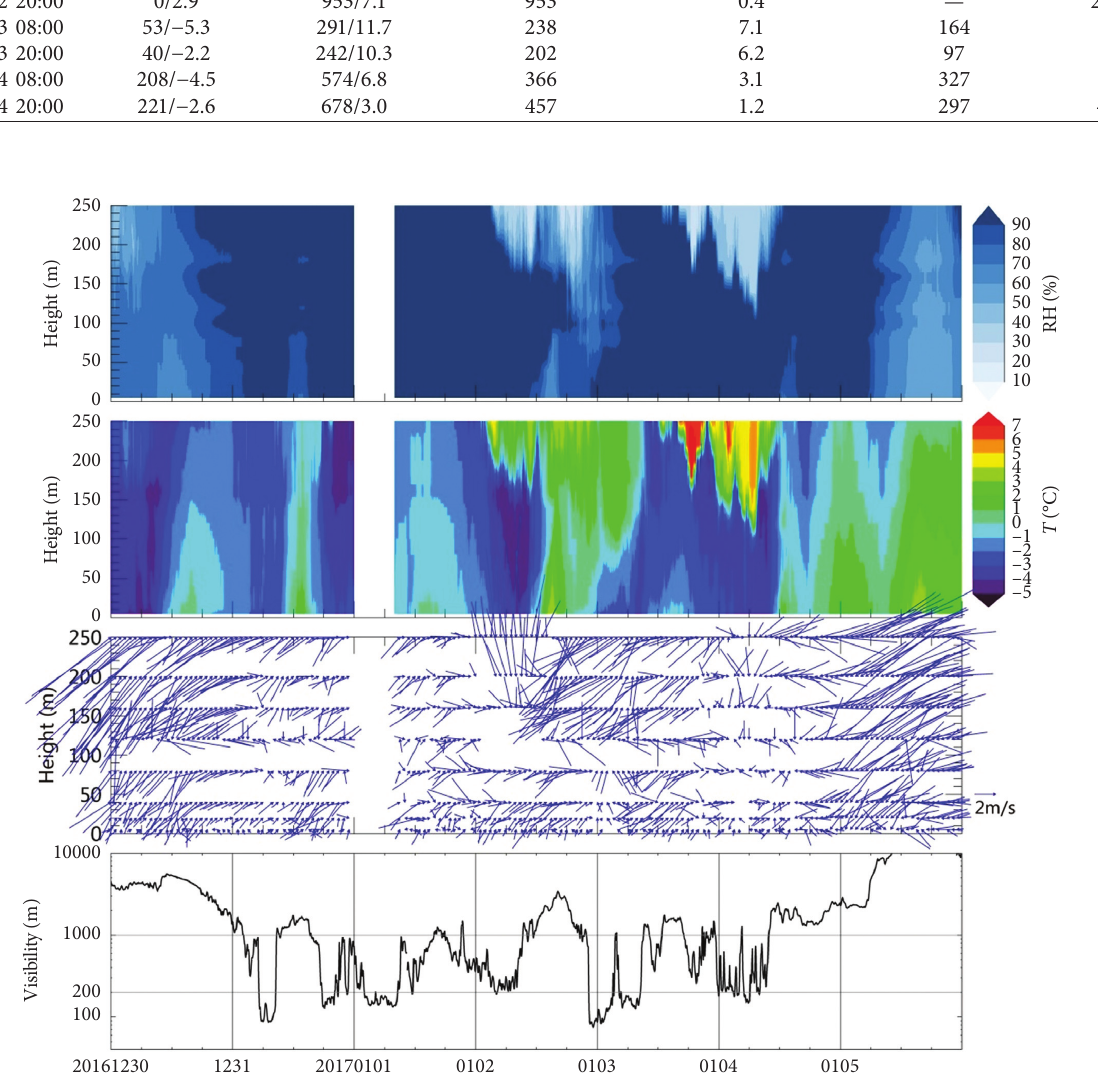
Figure 8: Evolution of relative humidity, temperature, and wind direction and wind speed profile and visibility of Tianjin Tower